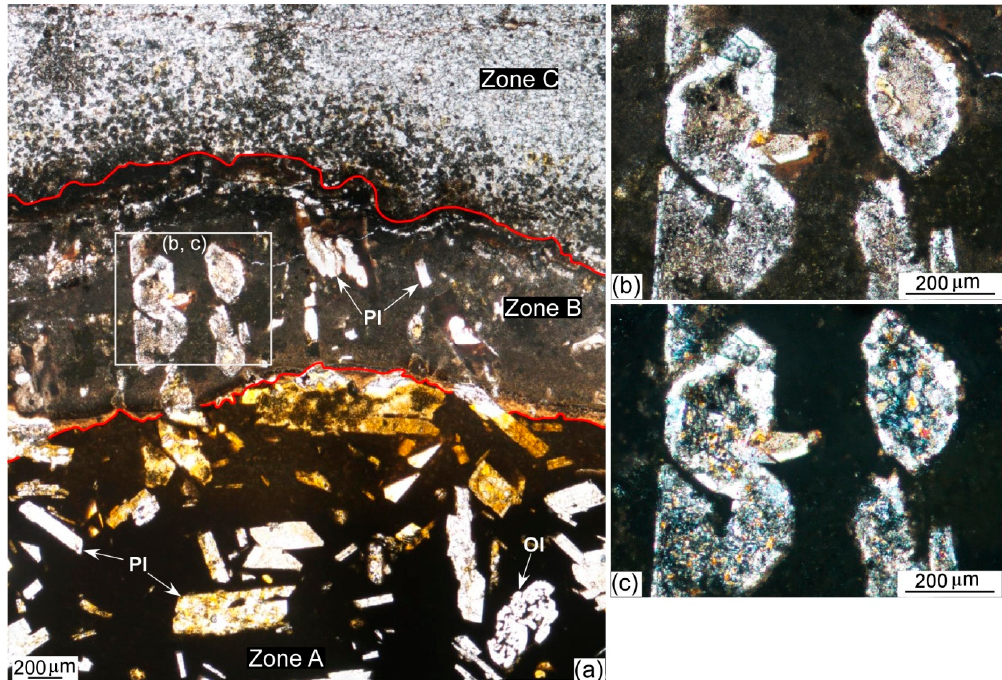
Figure 14. ( a ) Metasomatized basalt (zone B) preserving the porphyritic textures, and developed at the contact of the porphyritic, vitrophyric basalt (zone A) with the carbonate-rich country rock (zone C). ( b ) PPL and ( c ) XPL showing a close-up view of saussuritized plagioclase phenocrysts in the metasomatic zone B.